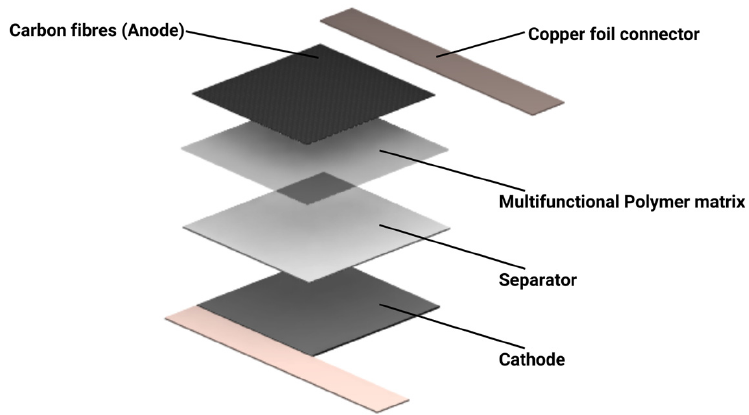
Figure 1. Structural composite